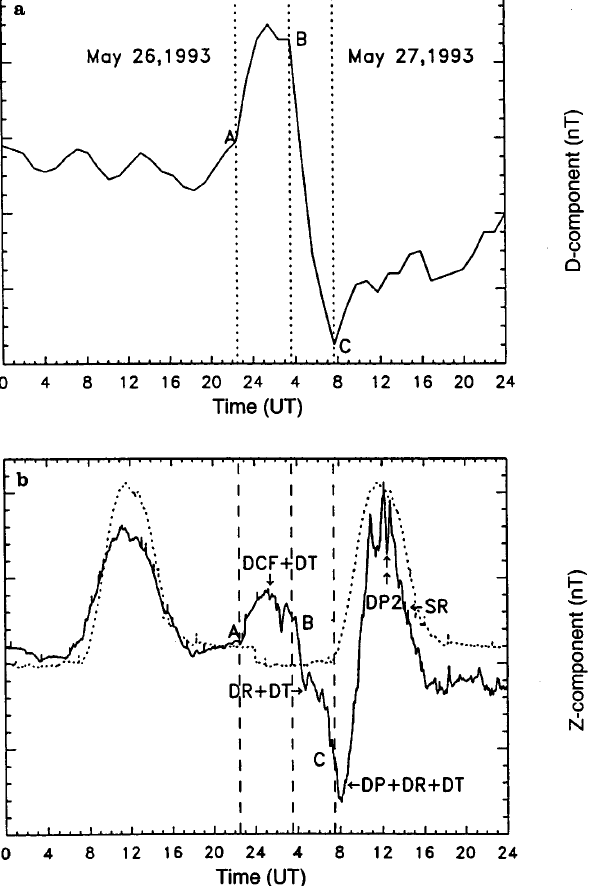
variations for 26 May (on the left) and 27 May 1993 ( on the right ) in solid line , overlaid by those of the reference quiet day (25 May 1993) in dotted line , at NIE (10.20 (cid:176) N; 05.63 (cid:176) W, dip: ) 01.20 (cid:176) ) near the EEJ maximum. NB: LT